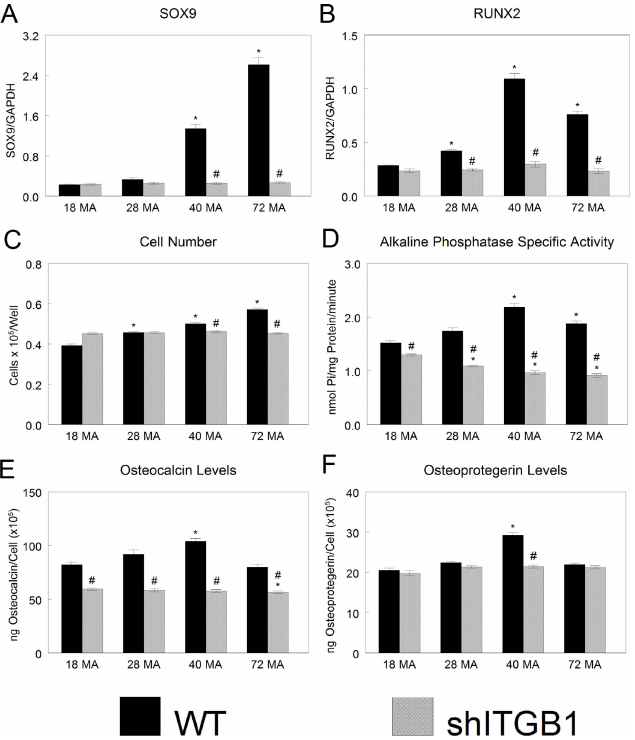
Fig 7. Integrin-dependent osteoblast differentiation. Levels of chondrogenic(A) and osteoblastic(B) mRNA. (C-F) Cell number and osteogenic protein levels in wild type humanMSCs (WT) and silencedintegrin β 1 MSCs (shITGB1) cultured on surfaces of varying stiffness. * P < 0.05 vs. 18 MA, # P < 0.05 vs. wild